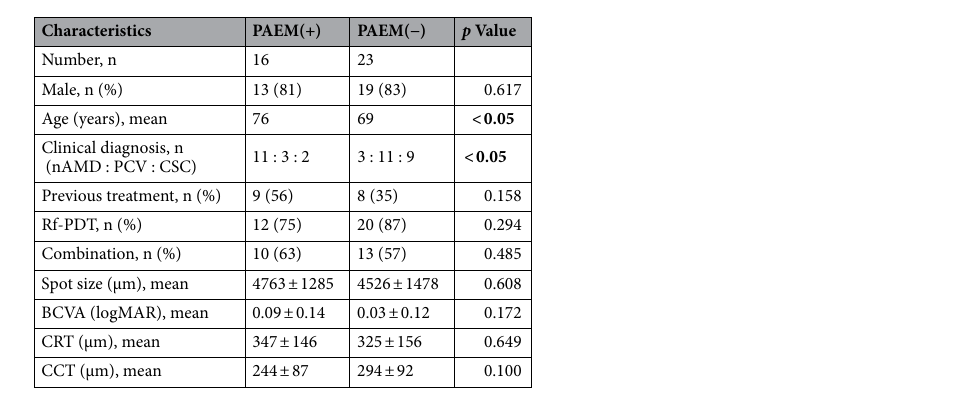
Table 3. Univariate analysis of factors associated with PAEM. Significant values are in bold.